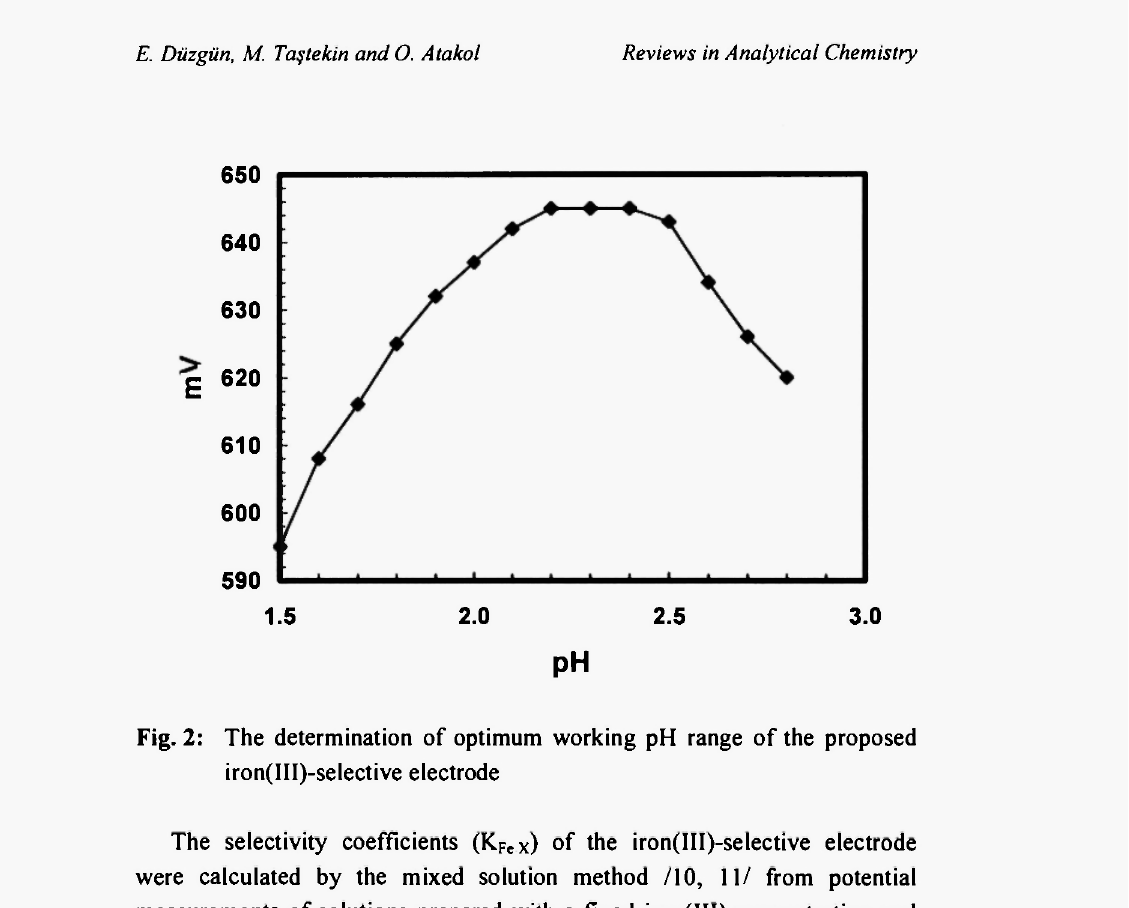
The determination of optimum working pH range of the proposed iron(III)-selective electrode The selectivity coefficients (K FeX ) of the iron(III)-selective electrode were calculated by the mixed solution method /10, 11/ from potential measurements of solutions prepared with a fixed iron(III) concentration and varying concentration of the interference ion. In this work, interference studies were made for Cr(III), Mn(II), Fe(II), Co(II), Ni(II), Cu(II), Zn(II), Ag(I) and Pb(II) ions. As can be seen from Table 1, the most interfering cations to the electrode are Ag(I), Cu(II) and Mn(II). This is the case for